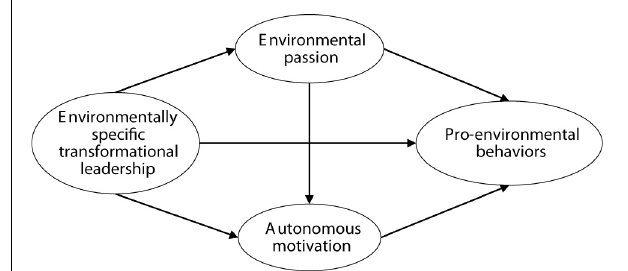
FIGURE 1 | Hypothetical